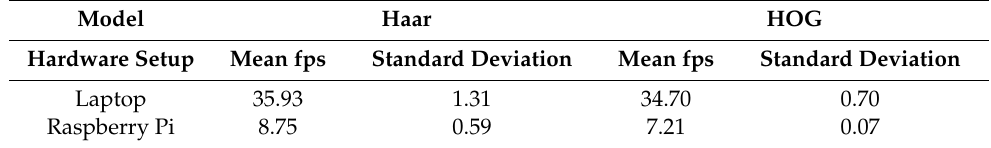
Table 2. Real-time response of face detection models in di ff erent hardware.